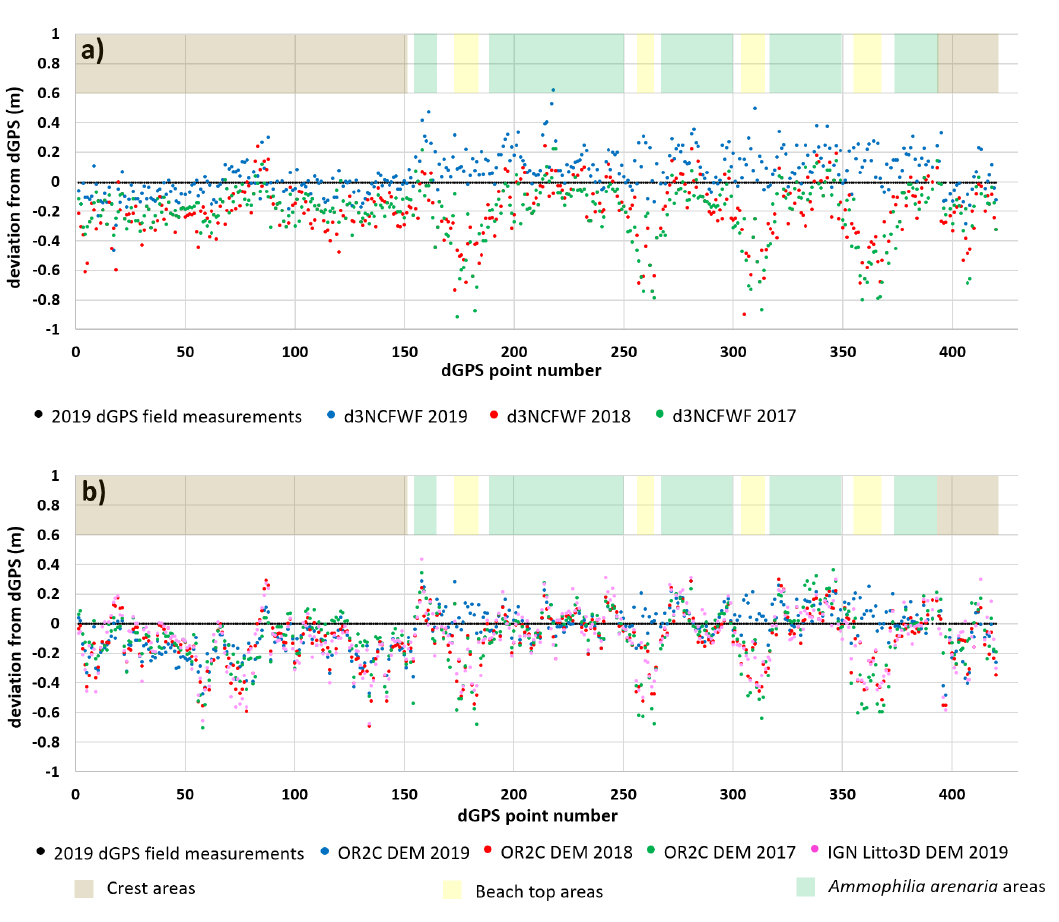
Figure 9. Deviation between the dGPS data and ( a ) the d3NCFWF’s first echo and ( b ) DTM data for 2017 ( green points ), 2018 ( red points ), and 2019 ( blue points ), as a function of the field sampling point number. The colored areas represent the different types of environments: crest sand paths ( brown ), beach top ( yellow ) and Ammophila arenaria ( green